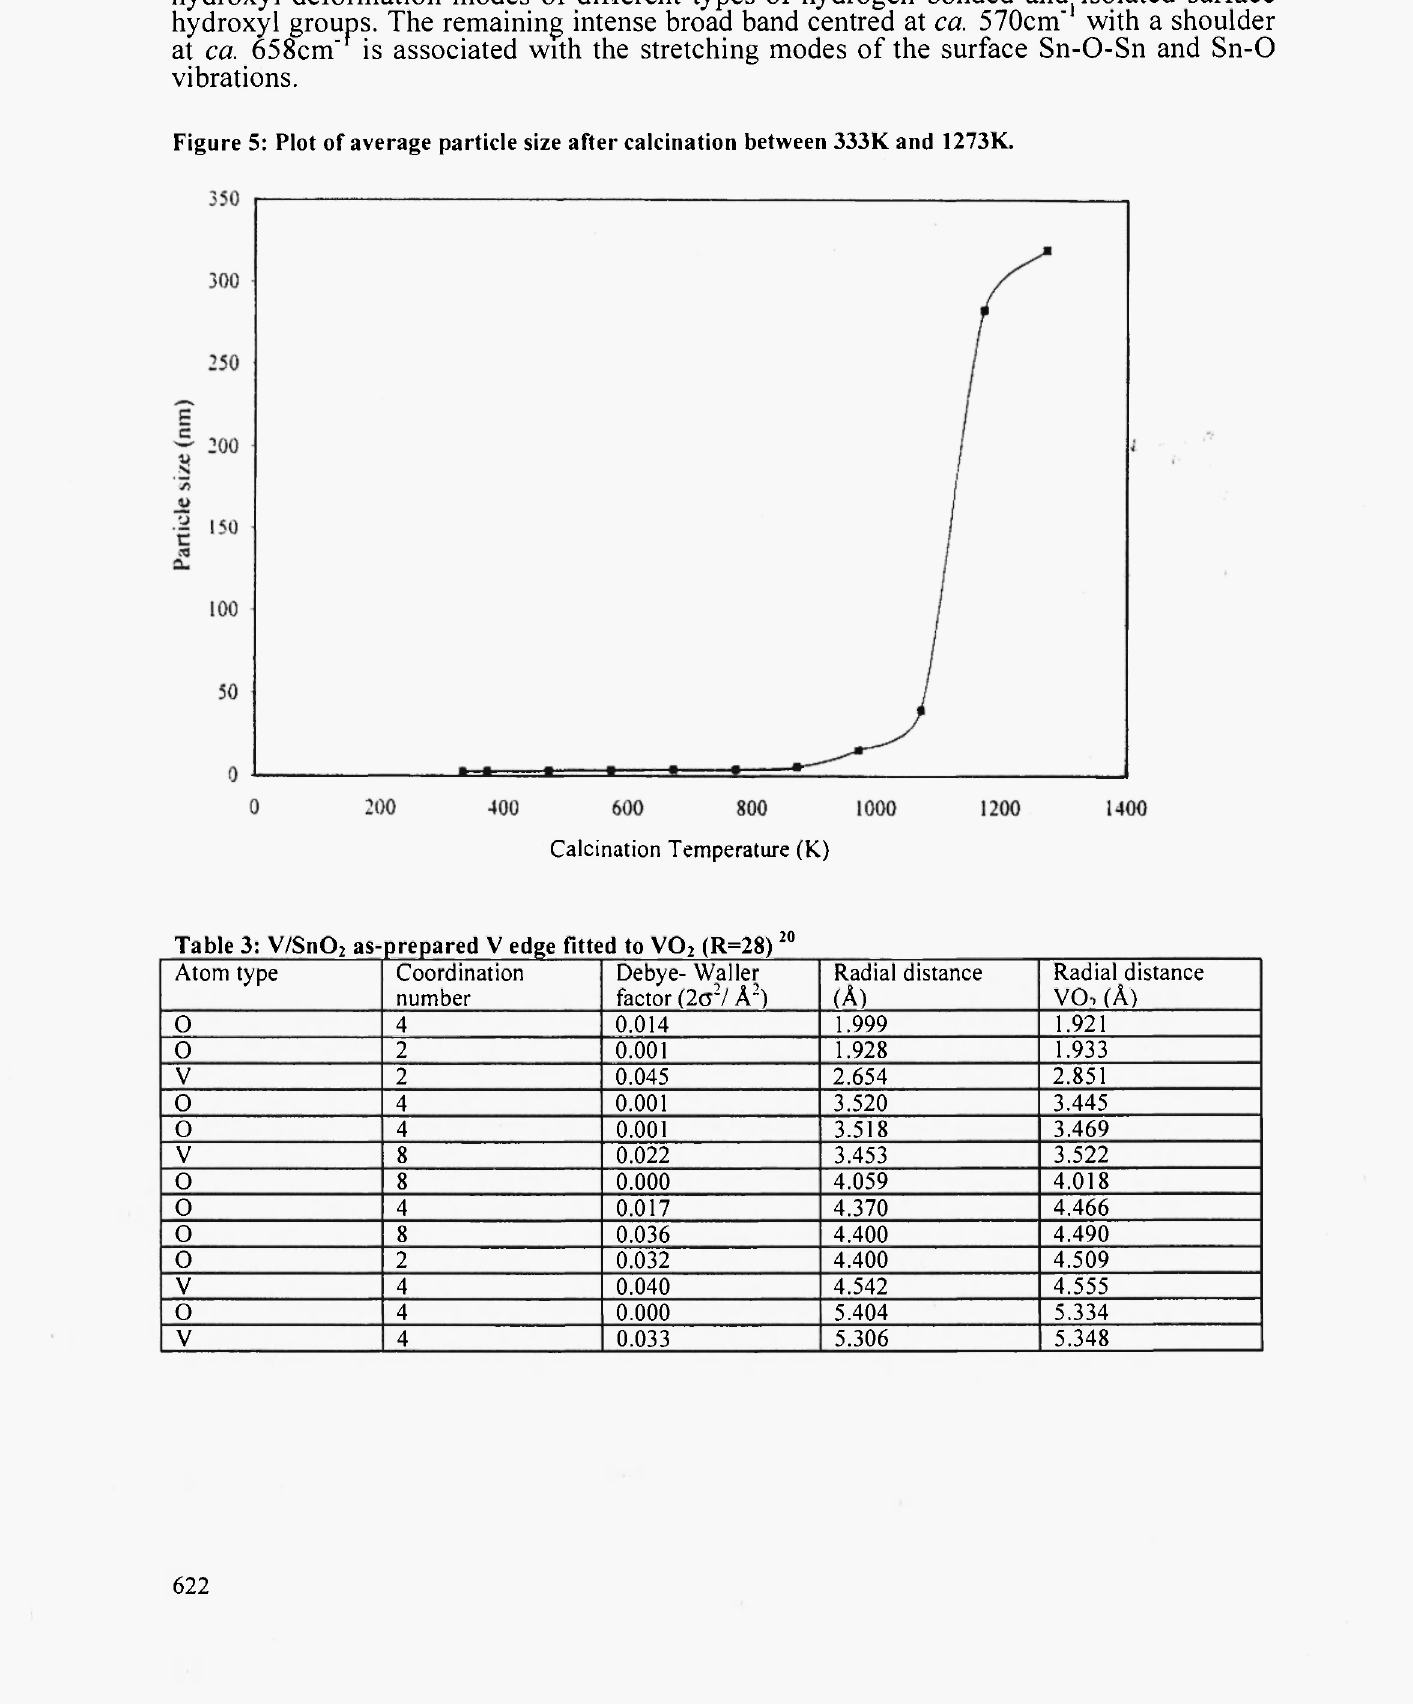
Figure 5: Plot of average particle size after calcination between 333K and 1273K.